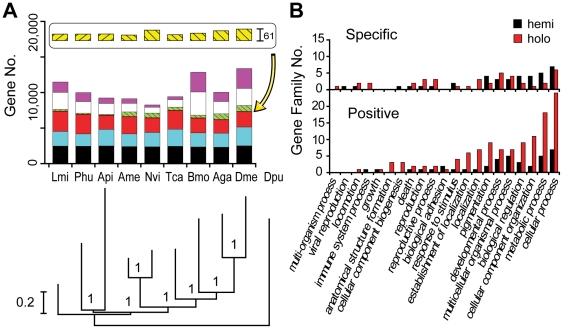
Comparative genomics and evolutionary lineage of insects.A. Insect gene orthology. The gene repertoire in nine insects: locust (LMI), body louse (PHU), and pea aphid (API) (Hemimetabola); fruit fly (DME), mosquito (AGA), silkworm (BMO), red flour beetle (TCA), honeybee (AME), and wasp (NVI) (Holometabola) were compared. Bar color indicates different orthologous relationships. Black: single-copy genes conserved in all insects (allowing one loss) (bottom). Blue: multiple-copy orthologs conserved in all insects (allowing one loss). Red: other orthologs presented in at least one hemimetabola and one holometabola. The striped boxes show hemimetabolous and holometabolous lineage specific orthologs, which were divided into genes conserved in all species in one lineage (lower yellow boxes, enlarged with an arrow) and those conserved in at least two species in the lineage but not all (upper green). White: partial homology but no orthology classified. Purple: species-specific genes. The phylogenetic tree was constructed using water flea (DPU) as outgroup, with numerals indicating estimated posterior probability. B. GO classification of hemimetabolous- (hemi) or holometabolous- (holo) specific gene families and gene families that underwent positive selection exclusively in hemi or holo insects.